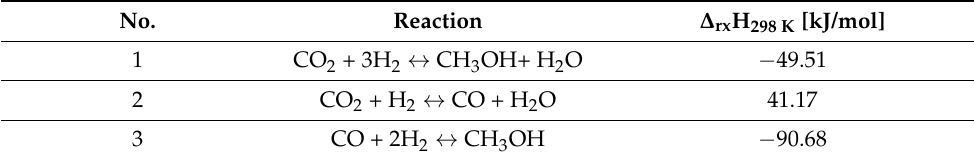
Table 1. Reactions involved in the hydrogenation of CO 2 into CH 3